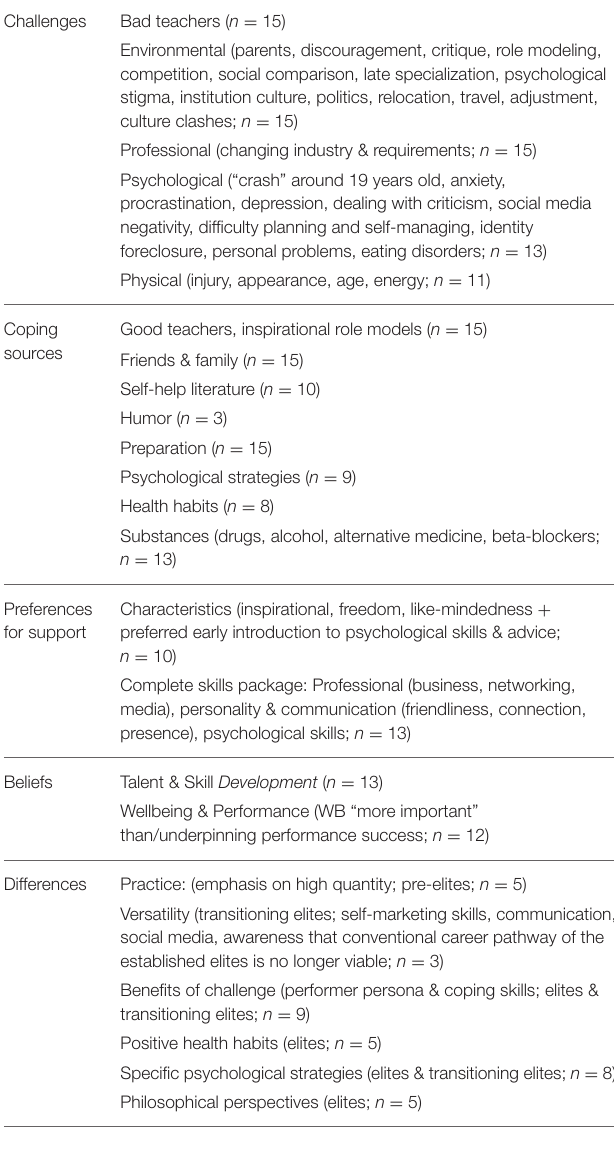
TABLE 1 | Emerging themes and subthemes following inductive content analysis.